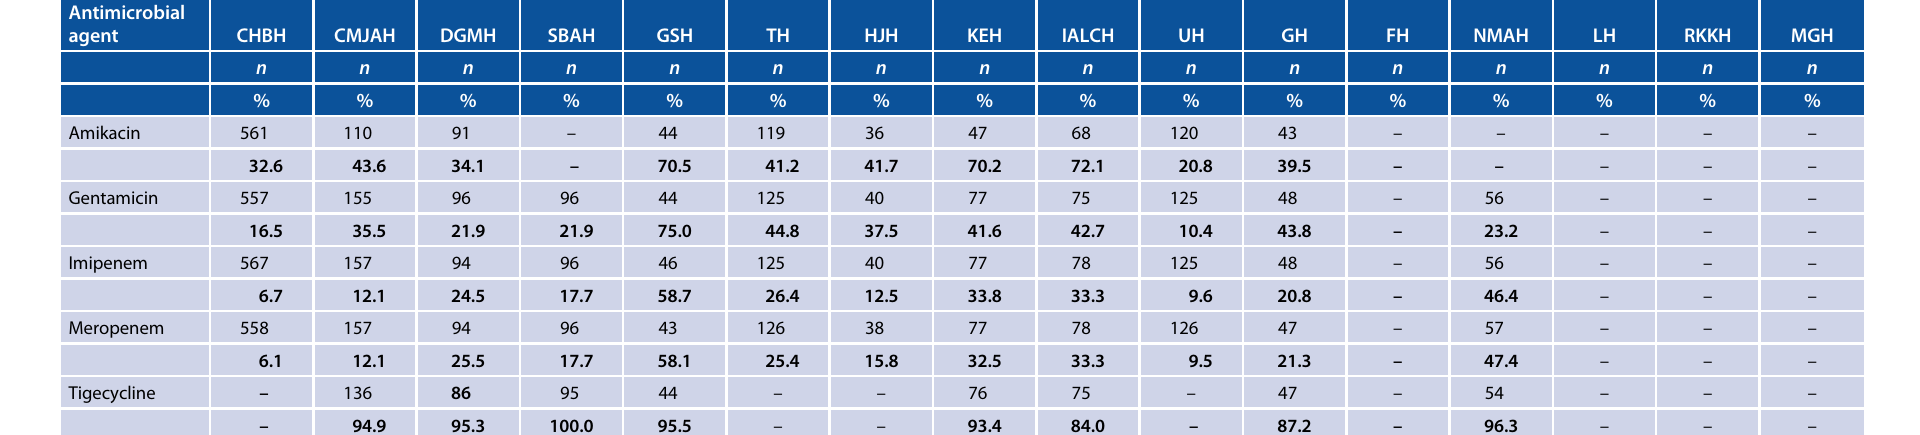
Table 7: Number and percentage of susceptible Acinetobacter baumannii isolates per antimicrobial agent from 16 sentinel hospitals across South Africa, January 1, 2016 to December 31, 2016 Antimicrobial agent